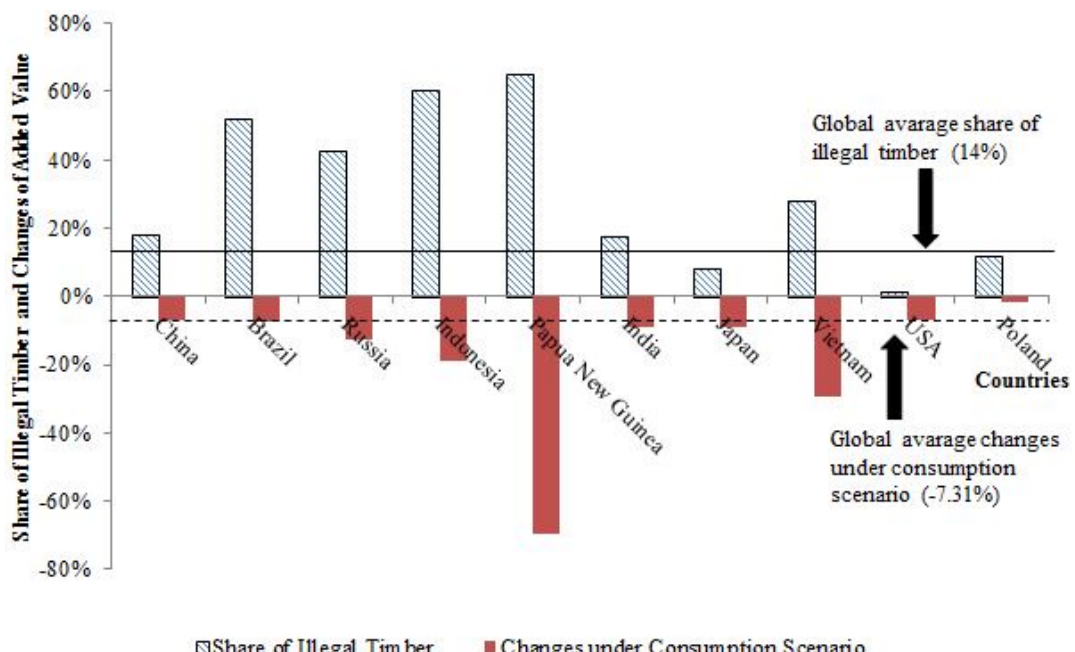
Figure 5. Shares of illegal wood fiber consumption in the domestic demand of final products and changes in added value under the consumption scenario in the top 10 consuming countries in 2030.